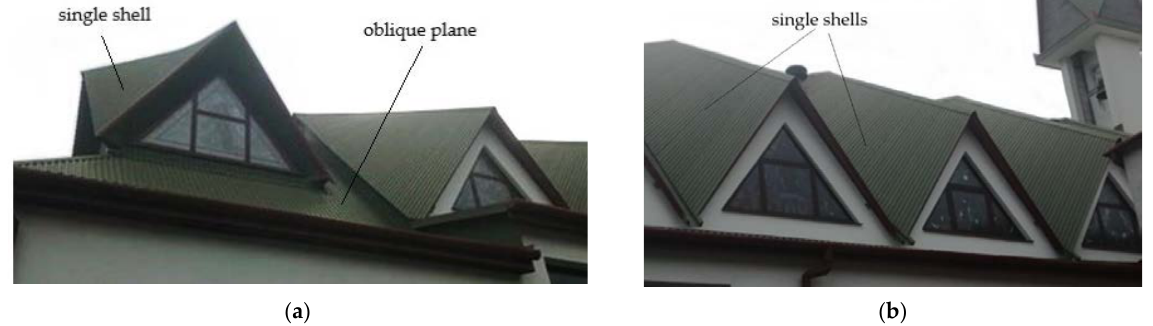
Figure 2. The external views of the same roof structure composed of several single shells arranged on an oblique plane: ( a ) the north side, ( b ) the south side.